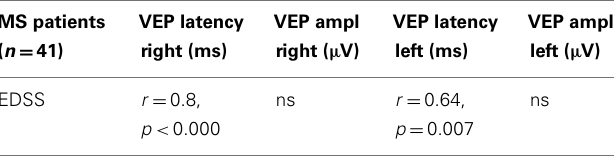
Table 4 | Correlation of EDSS andVEP latency andVEP amplitude in all MS patients .